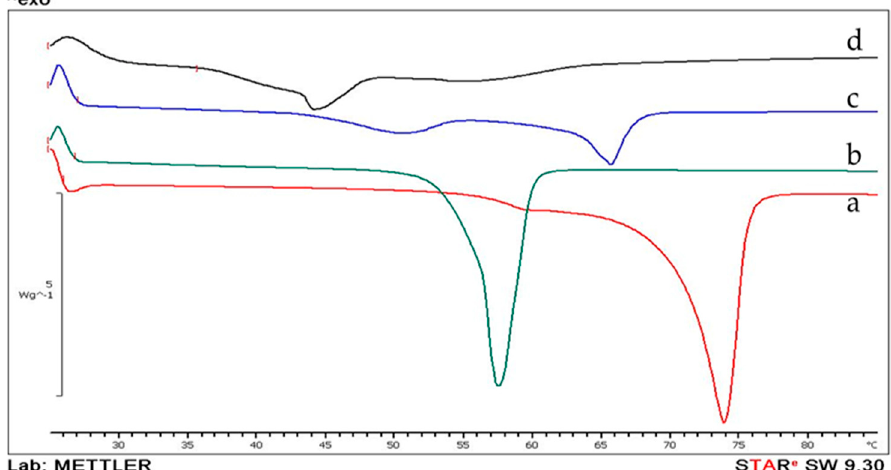
Figure 5. Differential scanning calorimetry thermograms of glyceryl monostearate ( a ), poloxamer 407 ( b ), SBO-NLCs ( c ), and blank NLCs ( d ). Table 5. The melting and enthalpy profile of the SBO-NLC and its composition. Samples